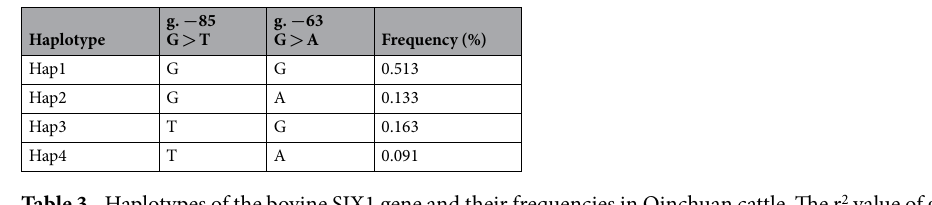
Table 3. Haplotypes of the bovine SIX1 gene and their frequencies in Qinchuan cattle. The r 2 value of g. − 85 G > T and g. − 63 G > A was